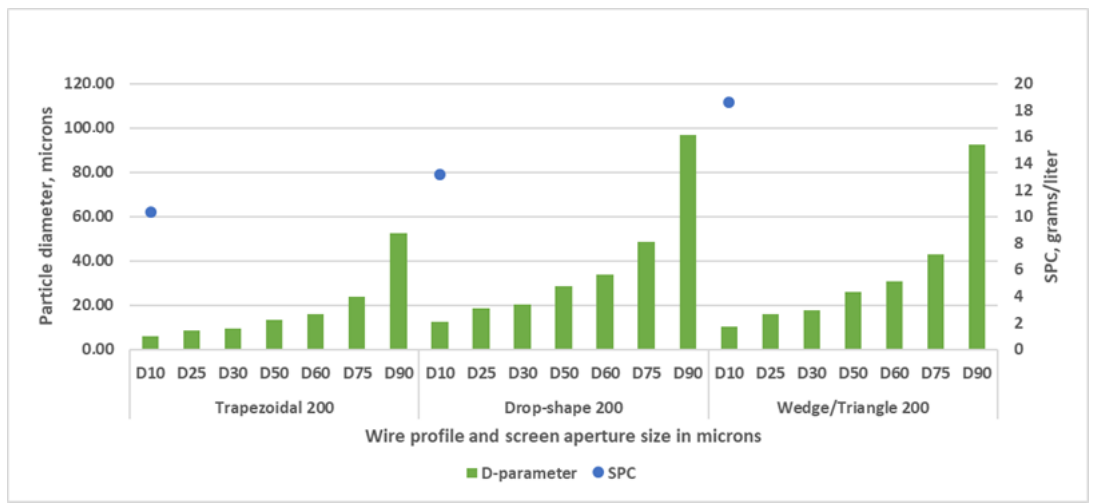
Figure 6. Experimental results for screens with an aperture size of 150 microns.